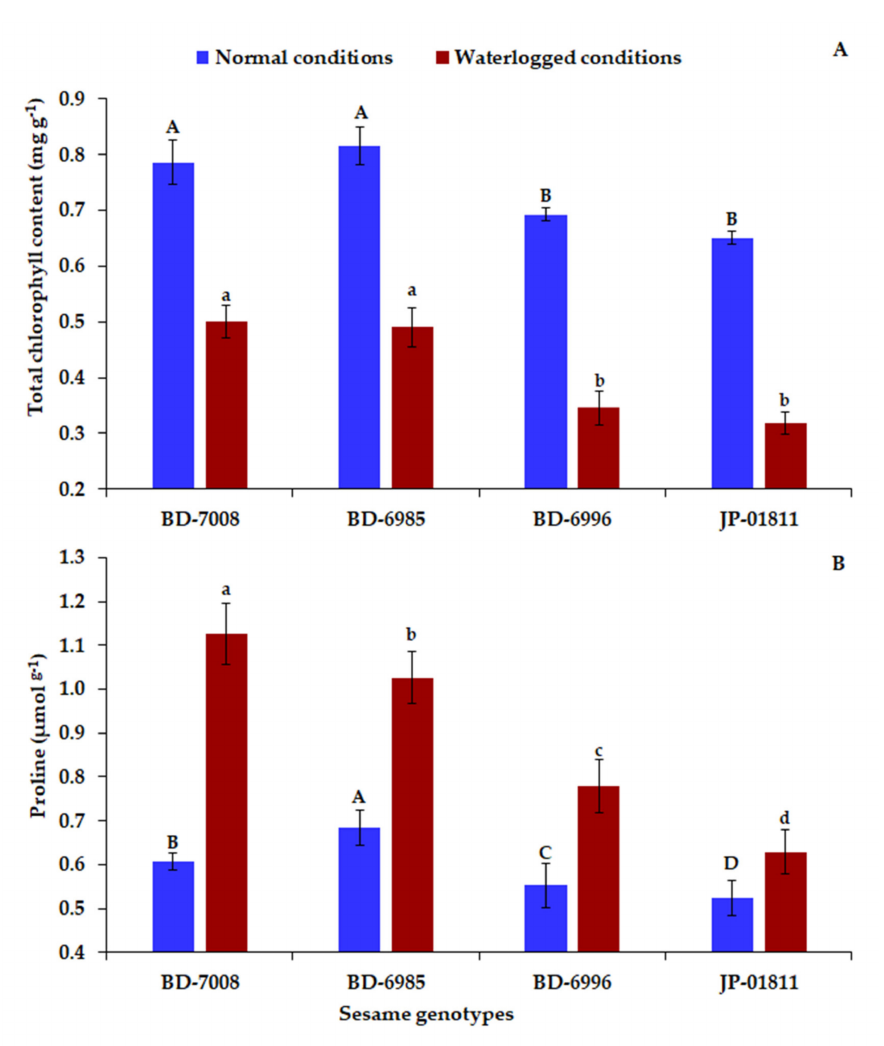
Figure 3. Total chlorophyll ( A ) and proline ( B ) contents of the four sesame genotypes at 48 h of waterlogging treatment. The bars on the columns correspond to SE and different uppercase letters indicate significant differences by LSD ( p < 0.01) under normal conditions, while lowercase letters indicate waterlogged